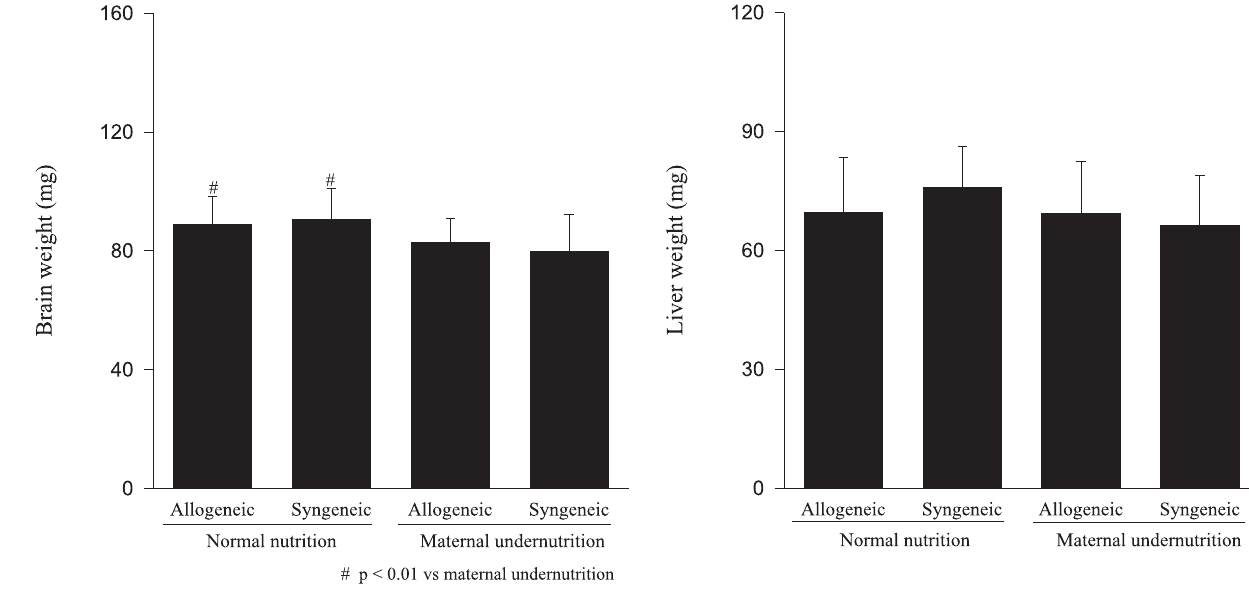
Figure 3 - Effect of type of maternal diet and maternal-fetal genetic compatibility on fetal brain weight (mean ± SD).